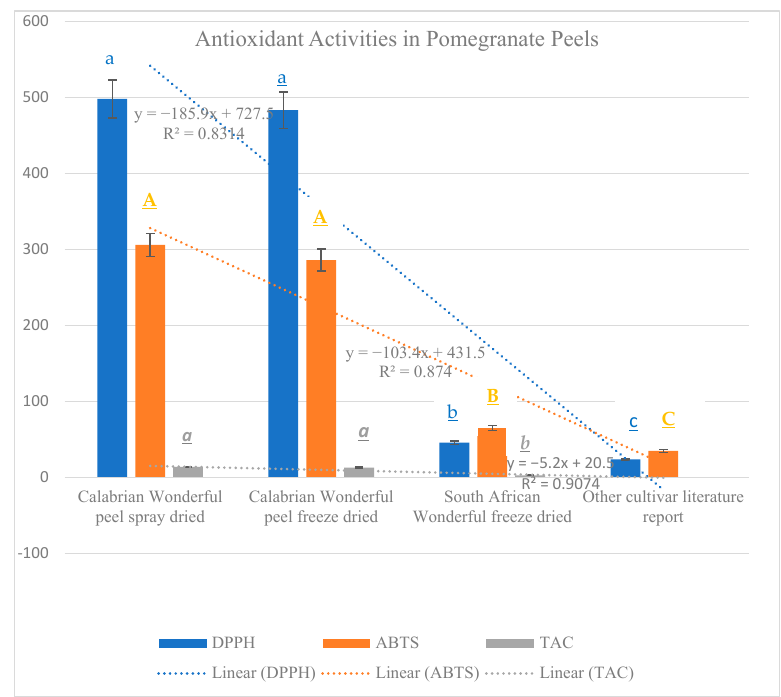
Figure 3. Antioxidant activities expressed as 2,2-diphenyl-1-picryl-hydrazyl-hydrate (DPPH), total antioxidant capacity (TAC), and 2,2 ′ -azino-bis-3-ethylbenzothiazoline-6-sulfonic acid (ABTS) in peels of different pomegranate cultivars dried differently. PSD (spray-dried Wonderful peel, experimental data); CFD (Calabrian Wonderful peel freeze-dried, experimental data); SAFD (South African Wonderful peel freeze-dried, literature data); IC (Indian cultivar peel freeze-dried, literature data). The experimental data are the mean of six replicates. Different letters indicate significant differences p ≤ 0.05. Lowercase (DPPH), capital (ABTS), and italic (TAC). Single phenolic acids were higher in Wonderful peels than in the peels of the other cultivars. In PSD, the greatest amount of single phenolic acids was detected (Table 1). El- lagic acid was the most abundant, followed in ranking by 2-5 dihydroxy-benzoic, gallic, protocatechuic, p -coumaric, chlorogenic, and ferulic acids. It has been widely demon- strated that ellagic acid (EA) is a potent antioxidant with antimicrobial, anti-inflamma- tory, neuroprotective, antihepatotoxic, anticholestatic, antifibrogenic, anticarcinogenic, cytotoxic, and antiviral effects [35]. Recently, Reis Jordão et al. [36] evidenced that ellagic acid can be a promising alternative treatment for hypertension and cardiovascular dis- ease, and Pei et al. [37] demonstrated that EA can be used to prevent diabetic cardiac dys- function. The doses of EA generally tested in the prevention health treatments were 30 mg/kg. PSD peel contained a great amount of EA (240 mg/g), suggesting its possible use as a nutraceutical supplement for the prevention of numerous diseases. Additionally, gal- lic, 2-5 dihydroxy-benzoic, protocatechuic, and ferulic acids have been found in a number of phytomedicines with diverse biological and pharmacological activities, including rad- ical scavenging, apoptosis of cancer cells, antihyperglycemic, antioxidant effects, and car- dioprotective activity [38–41]. Among the single flavonoids (Table 2), procyanidin 2, puni- calagin, procyanidin 1, and pelargonidin were, in this order, the most abundant com- pounds in PSD. Conversely, in the freeze-dried Calabrian and South African Wonderful